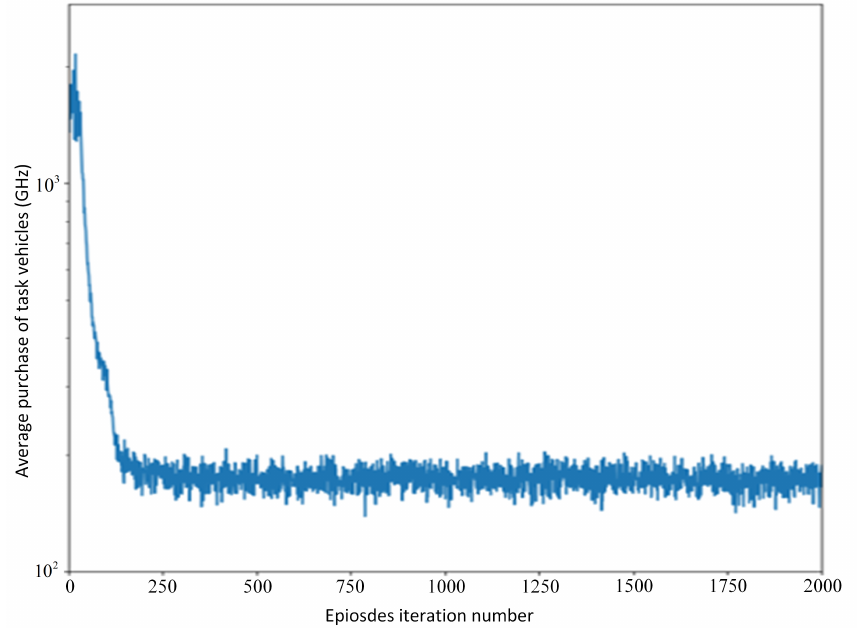
Figure 5. Average purchase for task